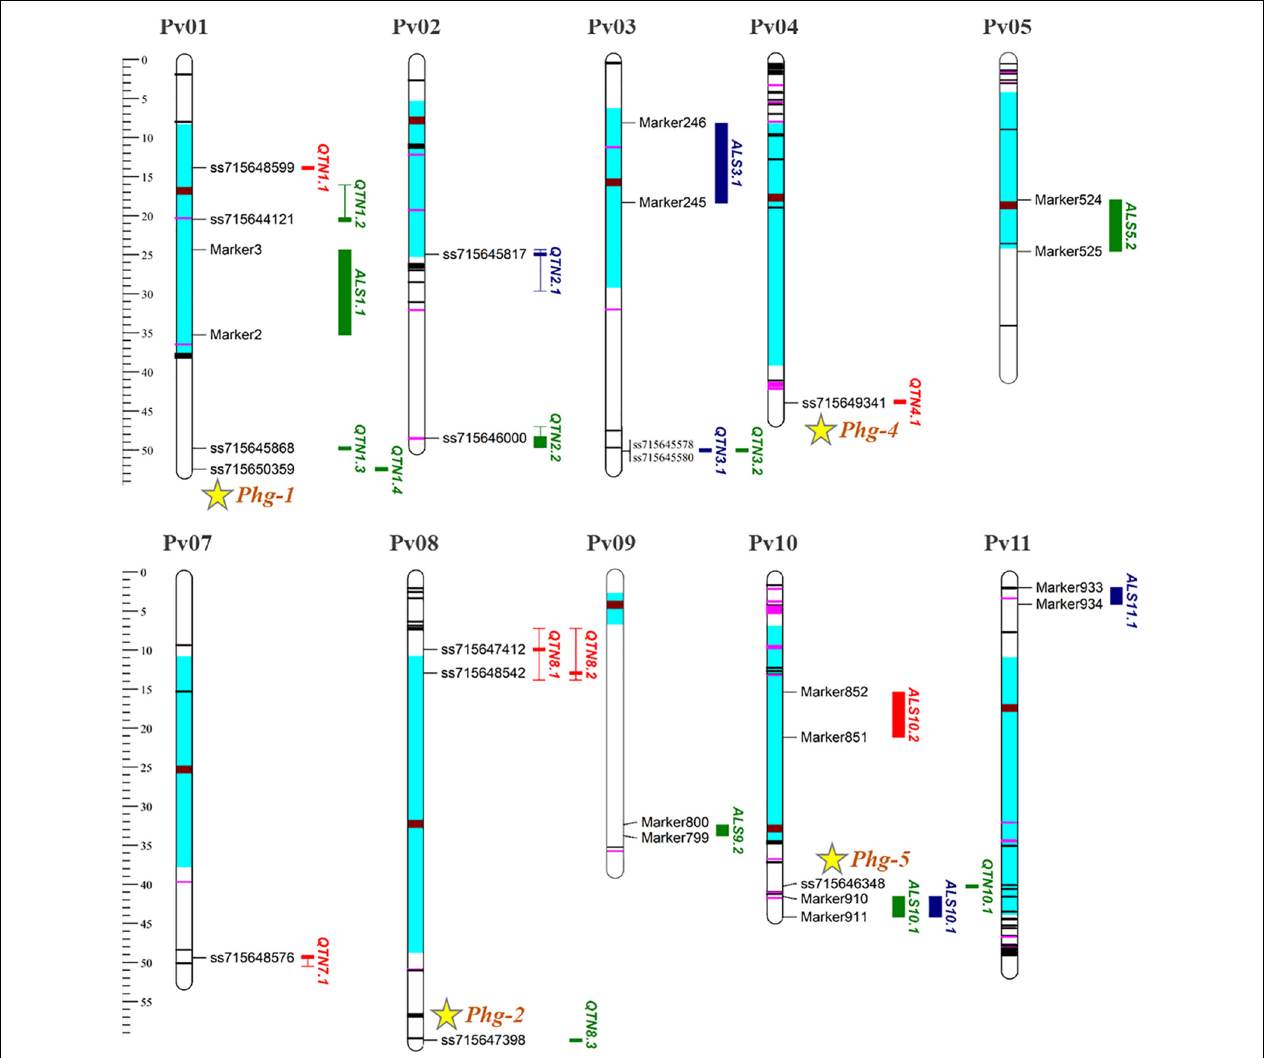
FIGURE 4 | Genetic mapping with the ALS resistance loci in different plant growth stages. The significant QTL and QTN represented by red, green, and blue bars on the right side of the chromosomes for the V2, V3, and R8 stages, respectively. The effective interval size of the QTN is given by the size of the haplotype blocks in LD and is represented by the length of the bar, with the filled part being the physical position of the significant SNP. The position of NB-LRR (NL) resistance genes containing nucleotide-binding and leucine-rich repeat domains are marked in black (CNL sequences) and pink (TNL sequences) according to Schmutz et al. (2014). Centromeric and pericentromeric regions are highlighted in brown and light blue. Physical positions provided in megabase pairs (Mb), according to reference